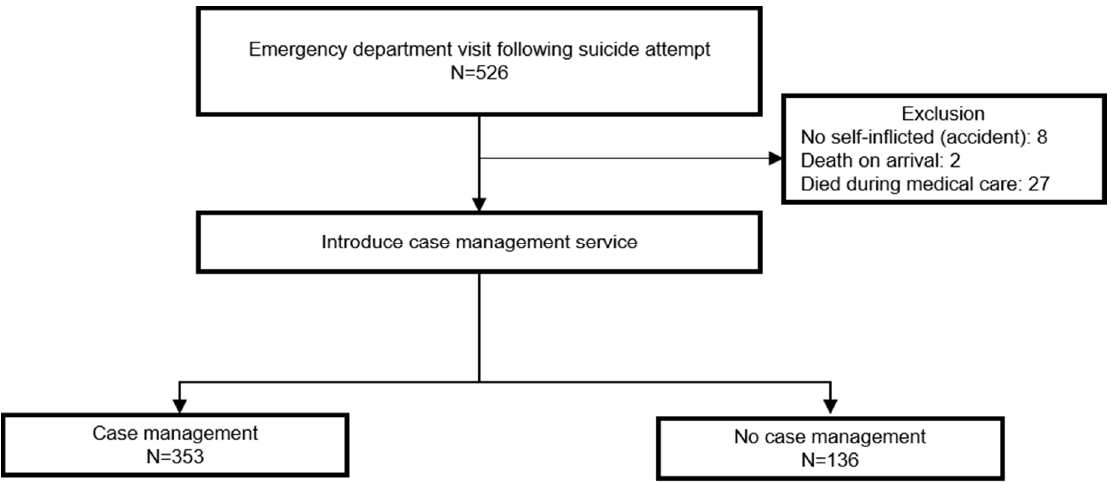
Figure 1. Flow chart of the study participants.